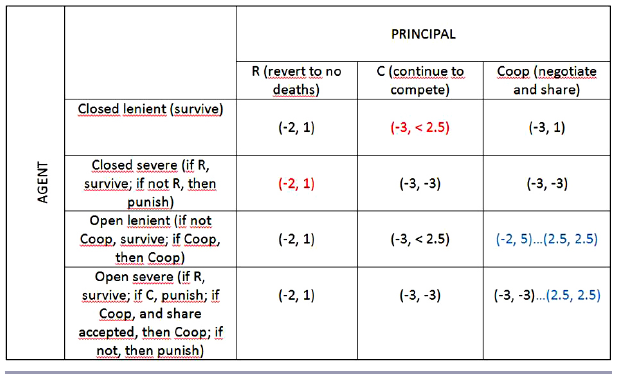
Fig. 4 . Normal form of the dismal game version 2. Payoffs as in version 1, except that those attainable by the principal in cases C, closed lenient, and in cases, C, open lenient, are no longer the maximum, but constrained for different reasons to values lower than 2.5. This allows strategic combinations, i.e., Coop, open lenient, and Coop, open severe, to Pareto dominate over all other Nash equilibria. Colored pairs (agent, principal) are Nash equilibria; blue pairs are also Pareto